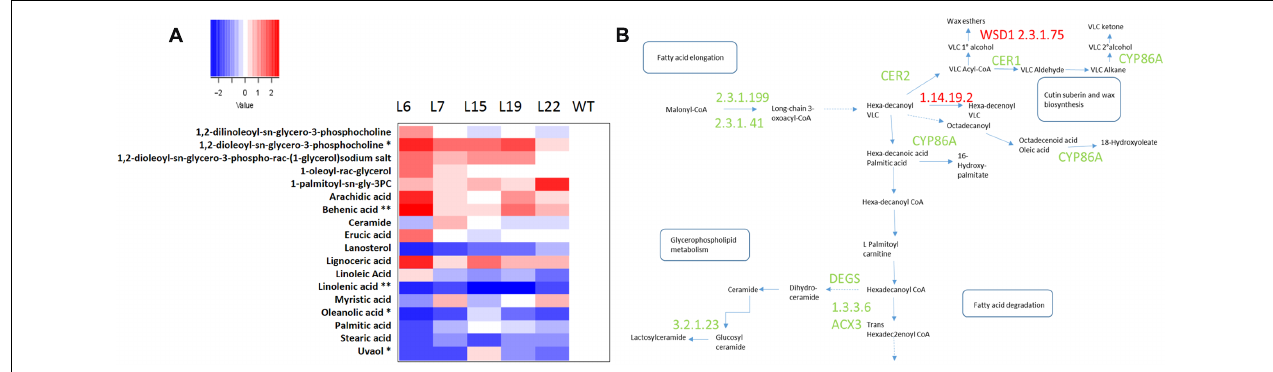
FIGURE 6 | Lipid content in VviERF045 overexpressing lines. (A) Heatmap representation for lipids content in the transgenic lines and WT. ( ∗ ) and ( ∗∗ ) indicates significant differences ( p < 0.05), and highly significant differences ( p < 0.01) for ANOVA and Tuckey’s tests, respectively. A legend with the color scale is reported on the top left part. (B) Transcripts involved in Fatty acid biosynthesis. 2.3.1.199 (LACS), 2.3.1.41 Beta-ketoacyl-CoA synthase ( VIT_00s0179g00380, VIT_16s0050g00830, VIT_01s0011g03490 ), 1.14.19.2 ( VIT_02s0012g02500 ) Acyl-[acyl-carrier-protein] desaturase, 1.3.3.6 Acyl-CoA oxidase (ACX3) ( VIT_02s0012g02920 ), 3.2.1.23 beta-galactosidase ( VIT_00s0404g00010 ), Sphingolipid delta 4 desaturase (DEGS) ( VIT_00s0583g00030 ) Sphingolipid delta 4 desaturase DES-1, CYP86A ( VIT_02s0025g03320 ), CYP86A ( VIT_07s0031g01680 ), CER1 Eceriferum 1 Sterol desaturase ( VIT_15s0021g00050 ), CER2 ( VIT_05s0029g00480 ), CER3 ( VIT_08s0007g00390 ), 2.3.1.75 WSD1 Wax Synthase desaturase 1 ( VIT_15s0046g00490 ) (Yeats et al., 2014). Green color means down-regulated gene, red color means